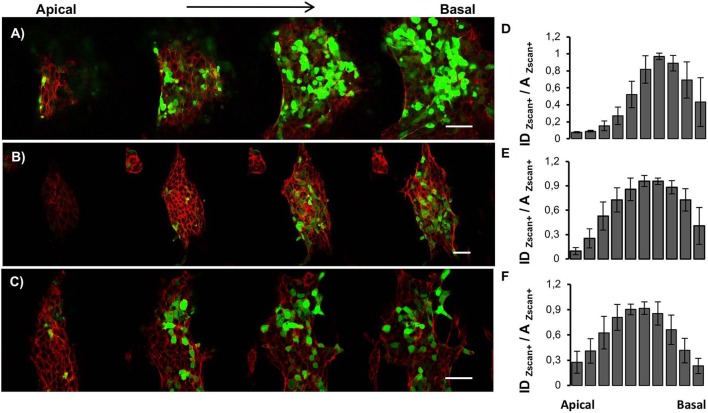
Spatial organization of Zscan+ cells within ESC colonies. Confocal z-scan imaging of actin cytoskeleton (red) and Zscan4 (green) of ESCs cultured for 72 h on flat control (A), ps-350 (B), and ps-700 (C) surfaces. Fluorescence intensity distribution profiles along with the thickness of ESCs cultured for 72 h on flat (D), ps-350 (E), and ps-700 (F) surfaces. For each experimental condition, 8 confocal z-scanning acquisitions were analyzed. Data are mean ± SD. Scale Bar is 50 μm.